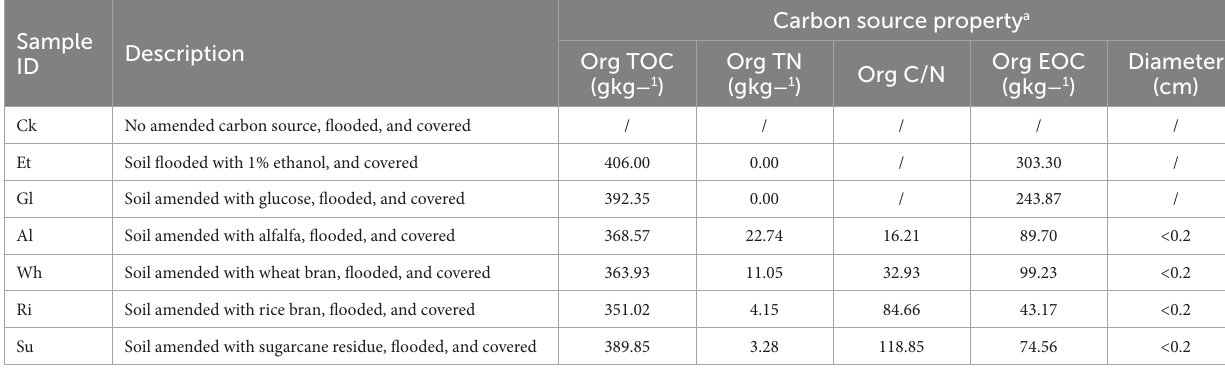
TABLE 1 Carbon source properties and treatment